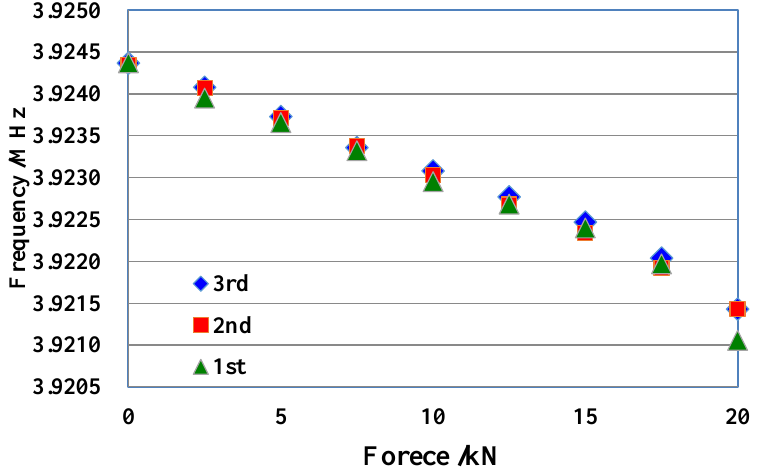
Figure 6. Susceptance frequency changes of the M16 bolt under different forces.